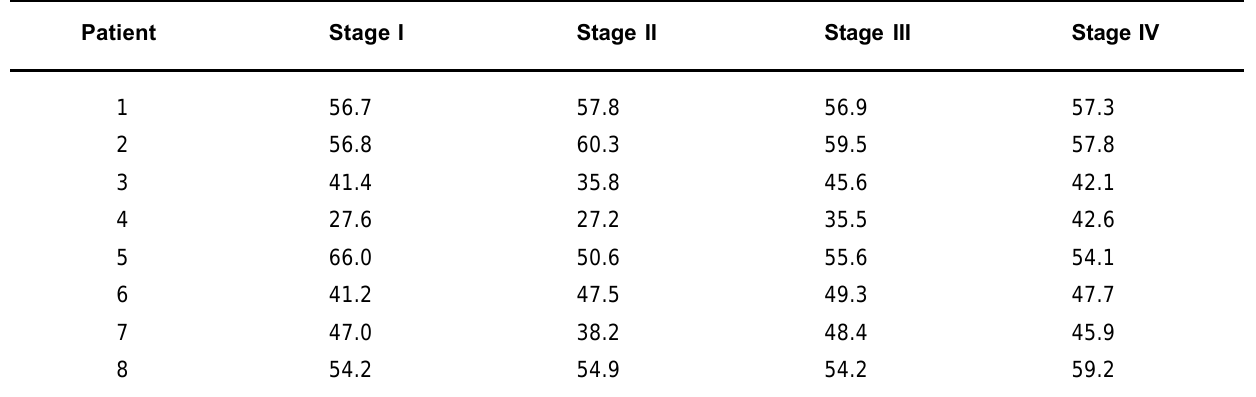
TABLE 2 - Mean opening mandibular movement recorded in the sagittal plane (in